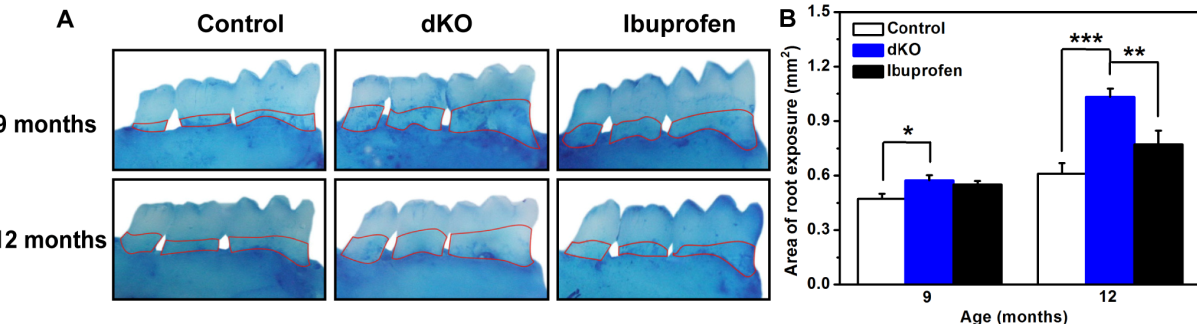
Figure 1. Alveolar bone loss ( A ) Mandibular lingual aspects of control mice at nine and 12 months of age (9 months n = 7, 12 months n = 9), naive double knockout mice (dKO mice) ( n = 9), and ibuprofen-treated dKO mice (9 months n = 8, 12 months n = 9). The area enclosed by the red line is the exposed molar root area; ( B ) Root exposure area (mm 2 ) of control, naive dKO, and ibuprofen-treated dKO mice at nine and 12 months of age. Values are mean ± SE for each group. * p < 0.05, ** p < 0.01, *** p <